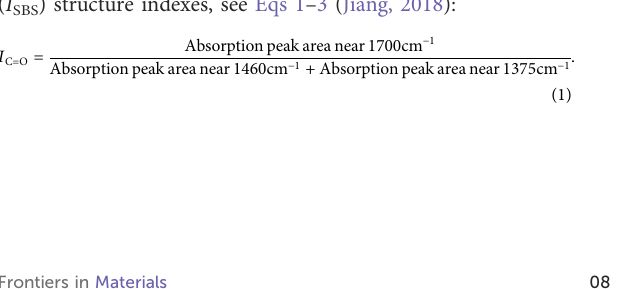
calculation formulas of carbonyl ( I C=O ), sulfoxide ( I S=O ), and SBS